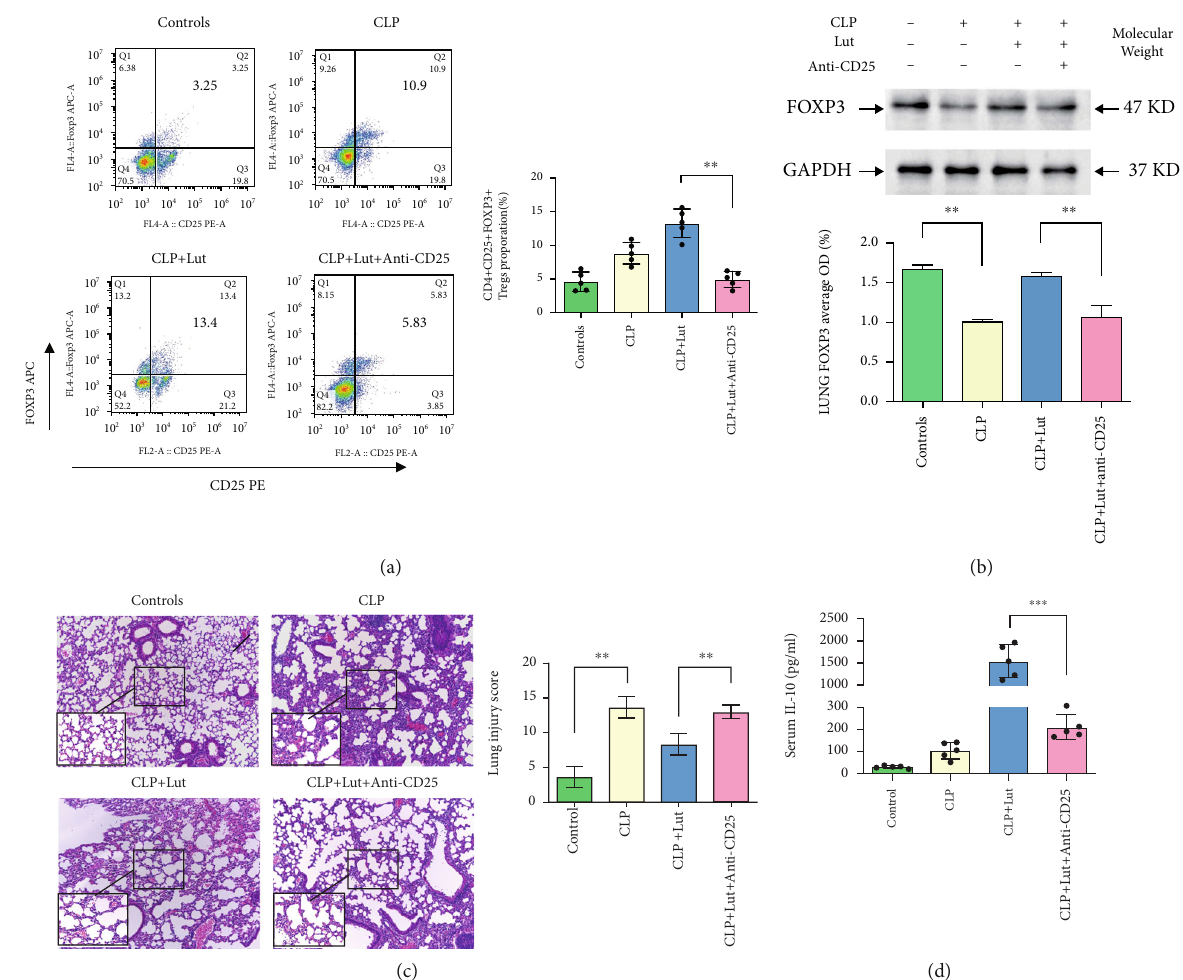
Figure 4: Luteolin plays a protective role in ALI, which is potentially linked to IL-10 and Tregs. (a, c, d) After treatment with CD25 neutralizing antibodies, the number of Tregs in the spleen of mice in the CLP+Lut group was signi fi cantly reduced. IL-10 expression was signi fi cantly reduced, and lung injury was signi fi cantly worse. CD4 + CD25 + FOXP3 + Tregs in splenic mononuclear cells were detected by fl ow cytometry. Lungs from each experimental group were stained with H&E and processed for histological examination. Mouse IL-10 serum levels were measured by ELISA. (b) After treatment with CD25 neutralizing antibodies, the expression of Foxp3 in lungs of GL+CLP mice was decreased. Foxp3 protein levels were measured by western blot. Each group n = 5 , experiments are repeatable, and the most representative one was shown. Data of the column graphs are presented as means ± SD . ∗∗ p < 0 : 01 and ∗∗∗ p < 0 : 001 between groups represented by horizontal lines, as calculated by one-way ANOVA followed by LSD multiple comparison